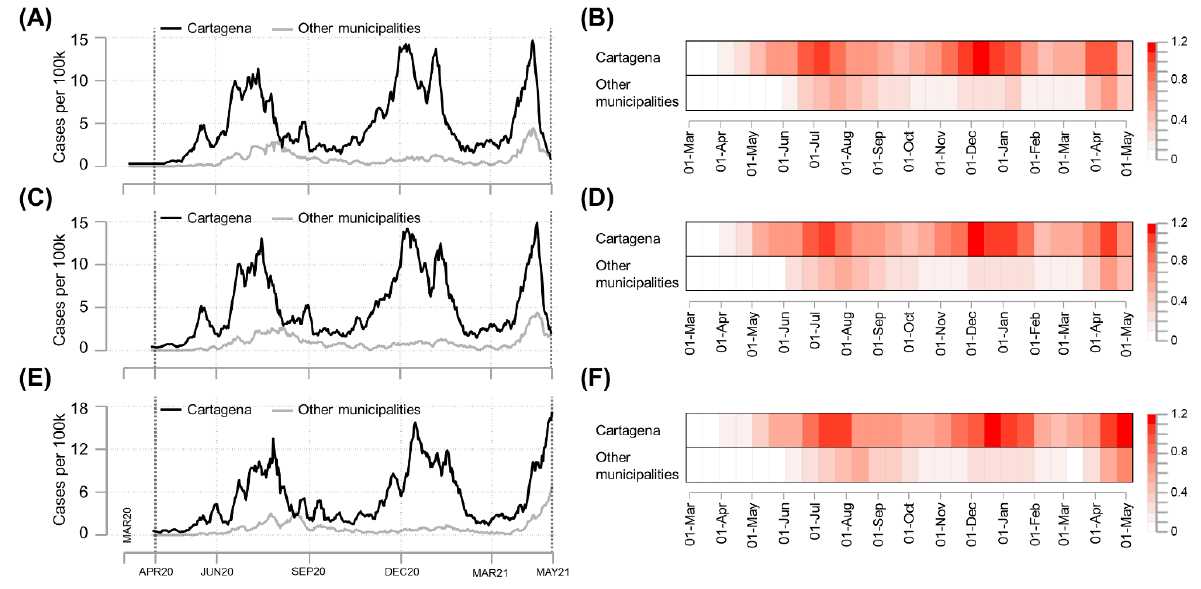
Figure 2. Epidemic curves and their patterns of daily new confirmed COVID-19 cases in Cartagena and other municipalities of Bolívar, as of 31 April 2021. Daily cases per 100,000 population were plotted using 7-day moving averages by date of symptom onset (panels ( A , B )), date of reporting (panels ( C , D )), and date of diagnosis (panels ( E , F )). Epidemic curves (panels ( A , C , E )) and heat maps (panels ( B , D , F ) ) were constructed using linear and “log (x + 1)” scales to improve readability, respectively.